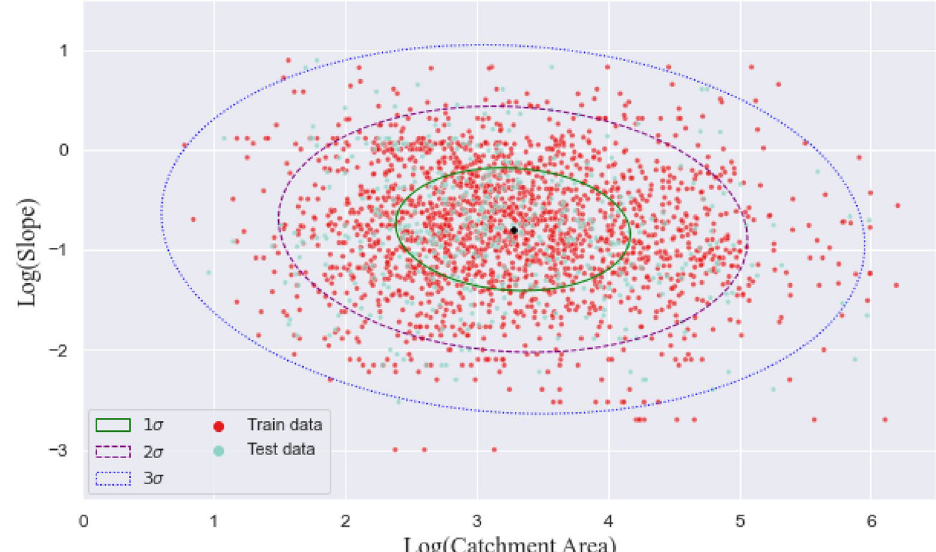
Fig. 4 Quantitative relationship between catchment area and slope obtained from the confidence ellipse approach with different standard deviations (i.e., 1 σ , 2 σ , and 3 σ )